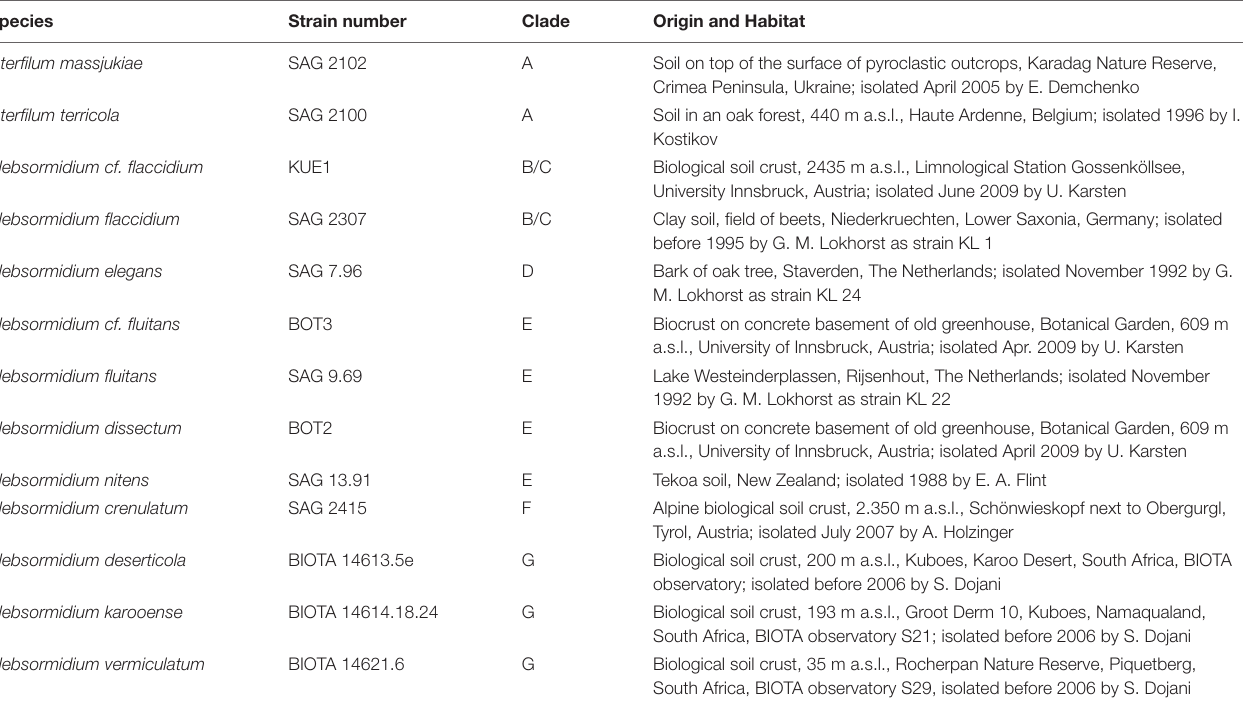
TABLE 1 | Species assignment, strain number (according to culture collections) or strain label (according earlier publications), genetic lineage (clade) assignment of Interfilum and Klebsormidium (according to Rindi et al., 2011; Mikhailyuk et al., 2015), habitat information on all isolates investigated. Species Strain number Clade Origin and